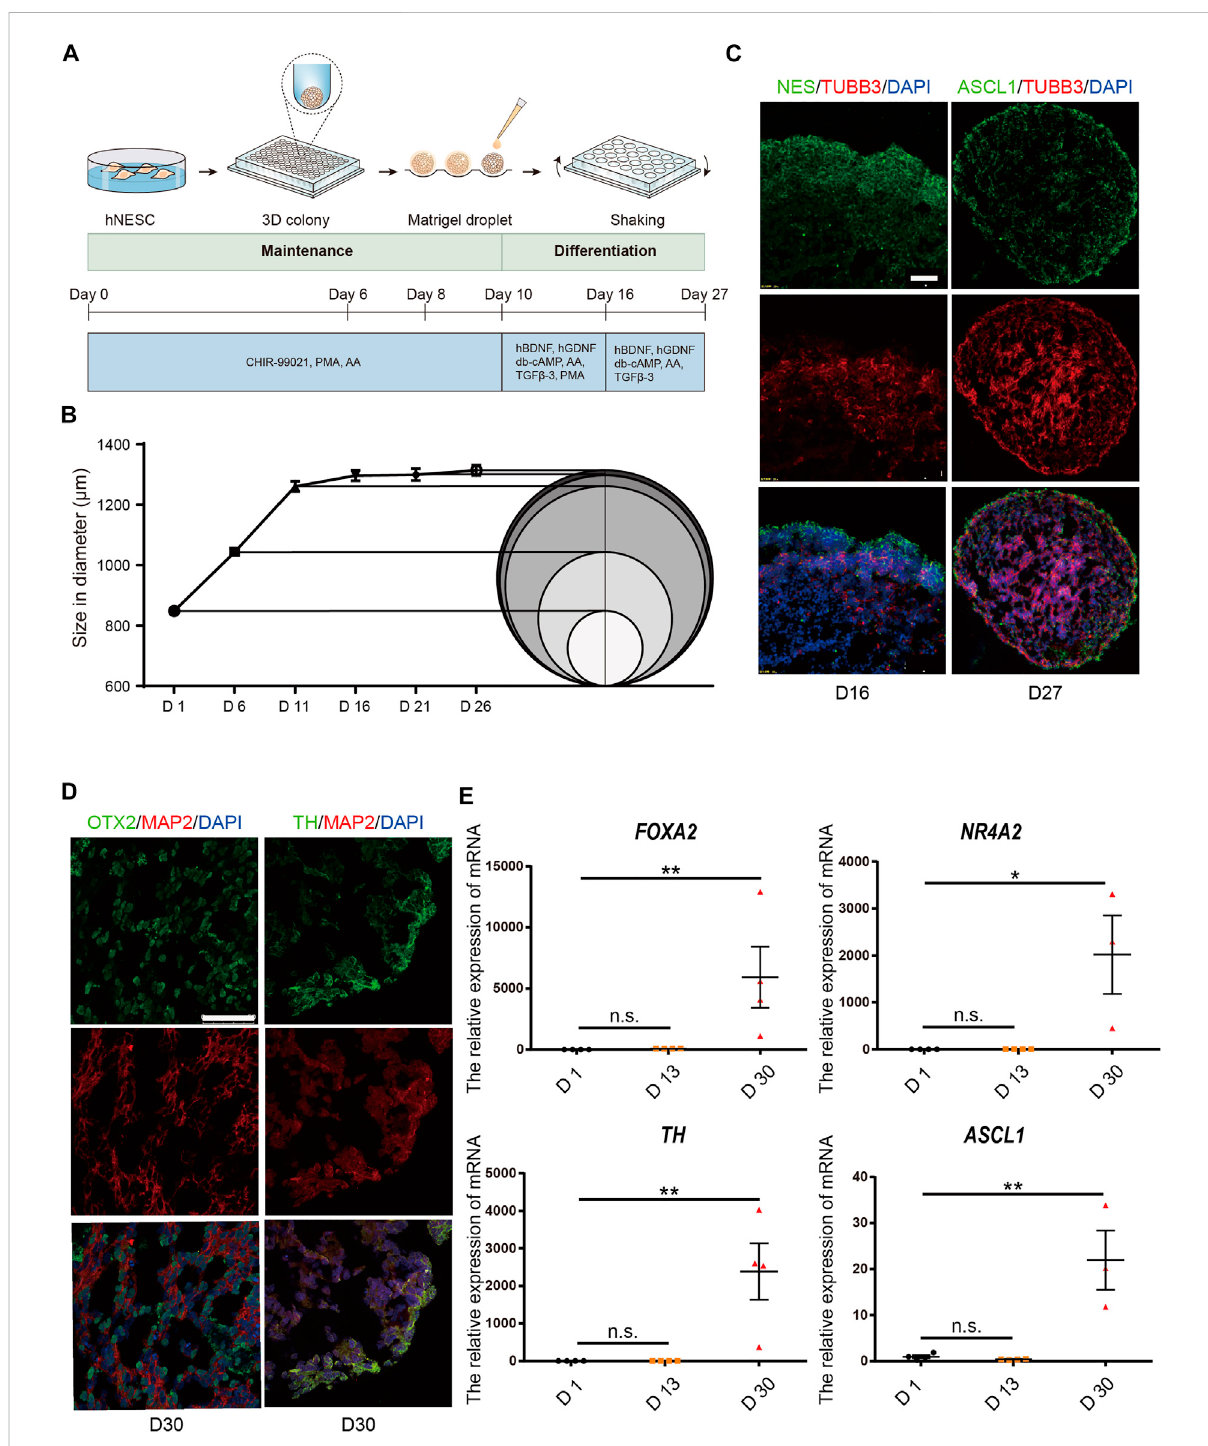
FIGURE 3 hMBOs mimicking the early stages of human midbrain development. (A) Schematic diagram of the hMBOs method and timing. (B) Diameter changes of hMBOs. (C) The immuno fl uorescence staining for NES (green), TUBB3 (red) on D16, and ASCL1 (green), TUBB3 (red) and DAPI (blue) on D27. (D) The immuno fl uorescence staining for OTX2 (green), MAP2 (red), TH (green) and DAPI (blue) in hMBOs on D27. (E) Detection of the mRNA expression of FOXA2, NURR1, TH and ASCL1. Images were captured on a Leica TCS SP8 STED confocal microscope. Scale bars: 50 μ